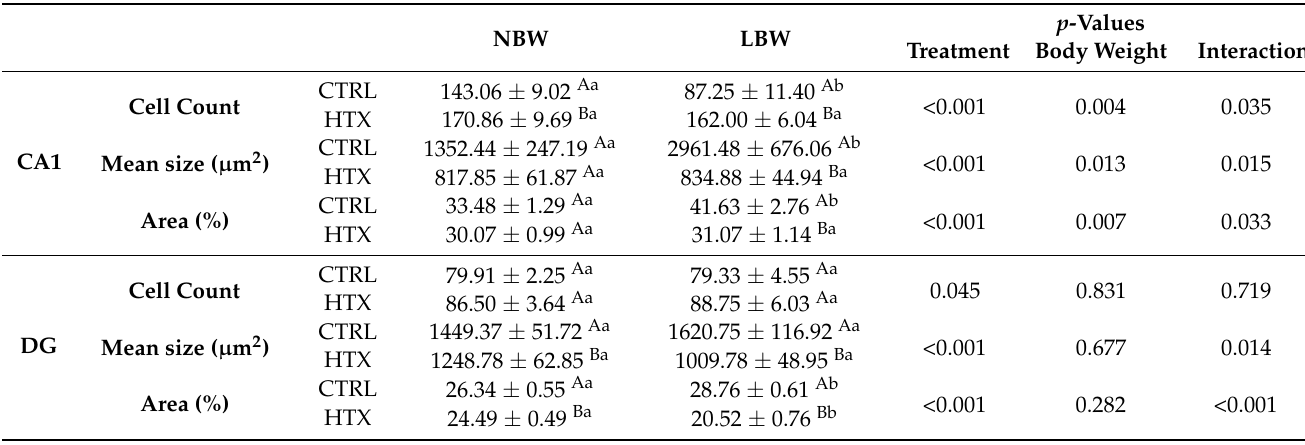
Table 1. Effect of body weight and supplementation of the maternal diet with hydroxytyrosol (HTX) on NeuN immunos- taining in the CA1 and DG areas of the hippocampus of 100-day-old fetuses. p -Values NBW LBW Treatment Body Weight